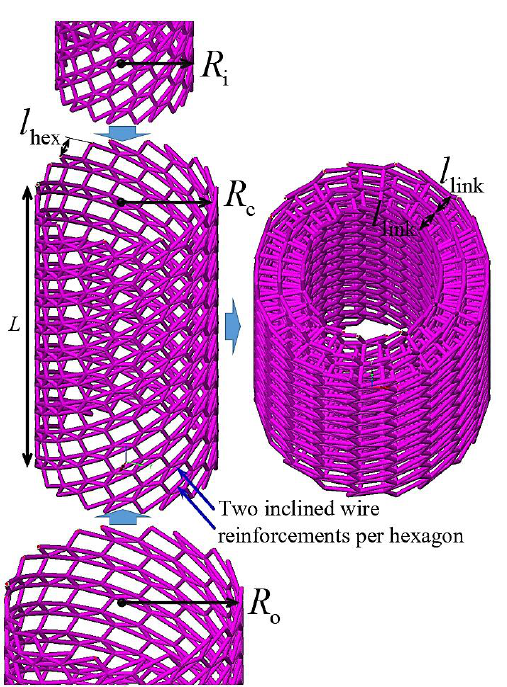
Figure 2. The architecture of the triple-wall